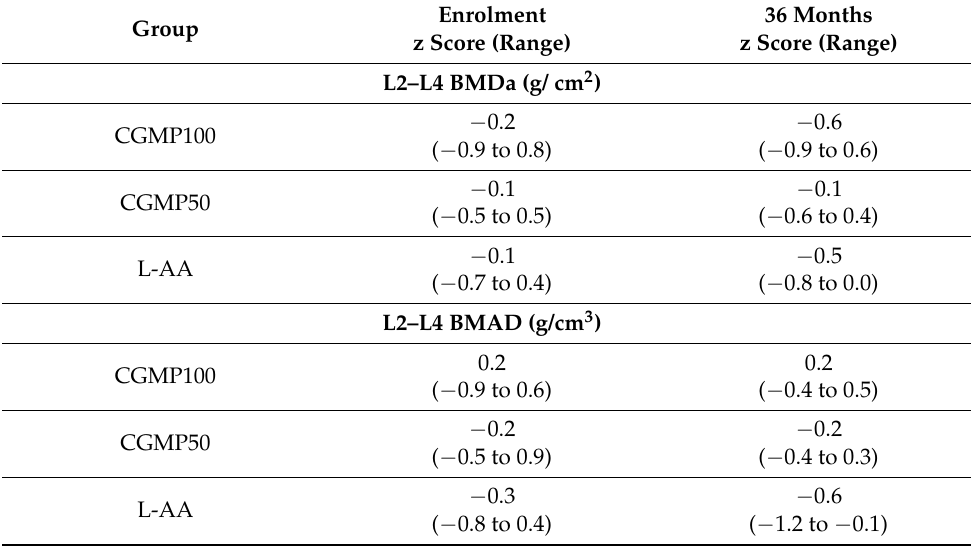
Table 2. Median z scores (range) for L2–L4 bone mineral density (BMDa), lumbar spine